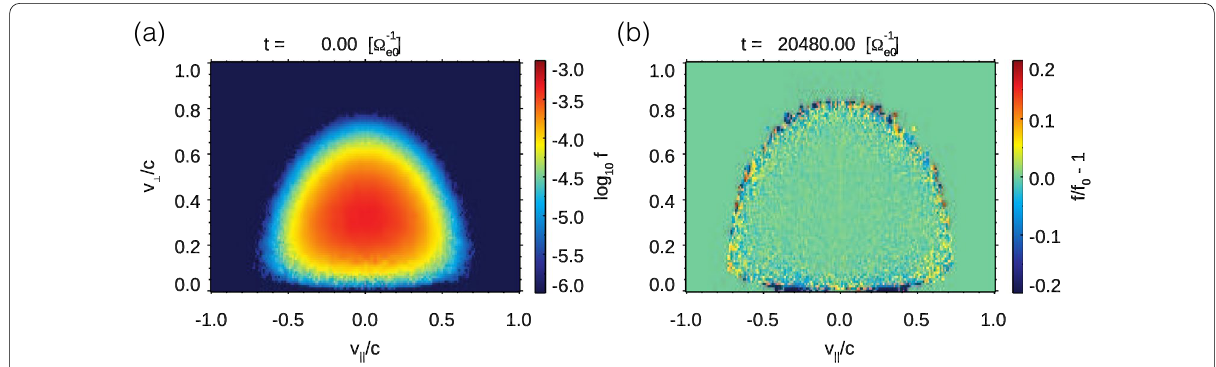
Fig. 1 a Initial velocity distribution of hot electrons with the parabolic gradient coefficient of the background magnetic field a = 1.87 × 10 − 7 (� e 0 / c ) 2 (i.e., Case 1) in the space range of h = − 50 ∼ 50 [ c (cid:31) − 1 e 0 ] ; b variation of the velocity distribution at t = 20480 [ (cid:31) − 1 e 0 ]